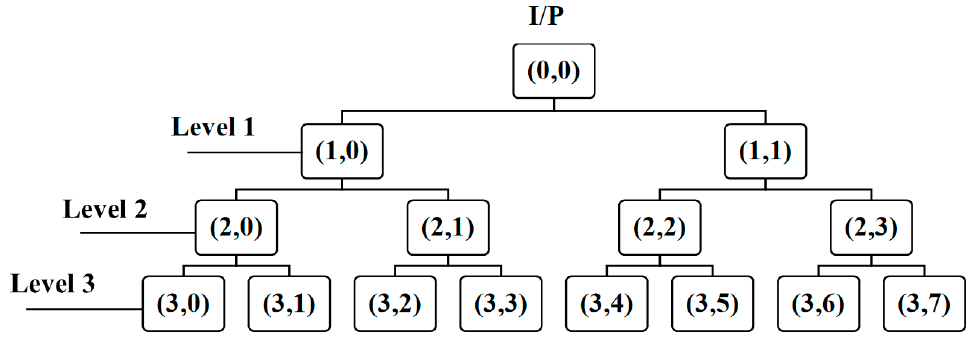
Figure 3. An illustration of a three-level wavelet packet tree decomposition, where I/P stands for input.